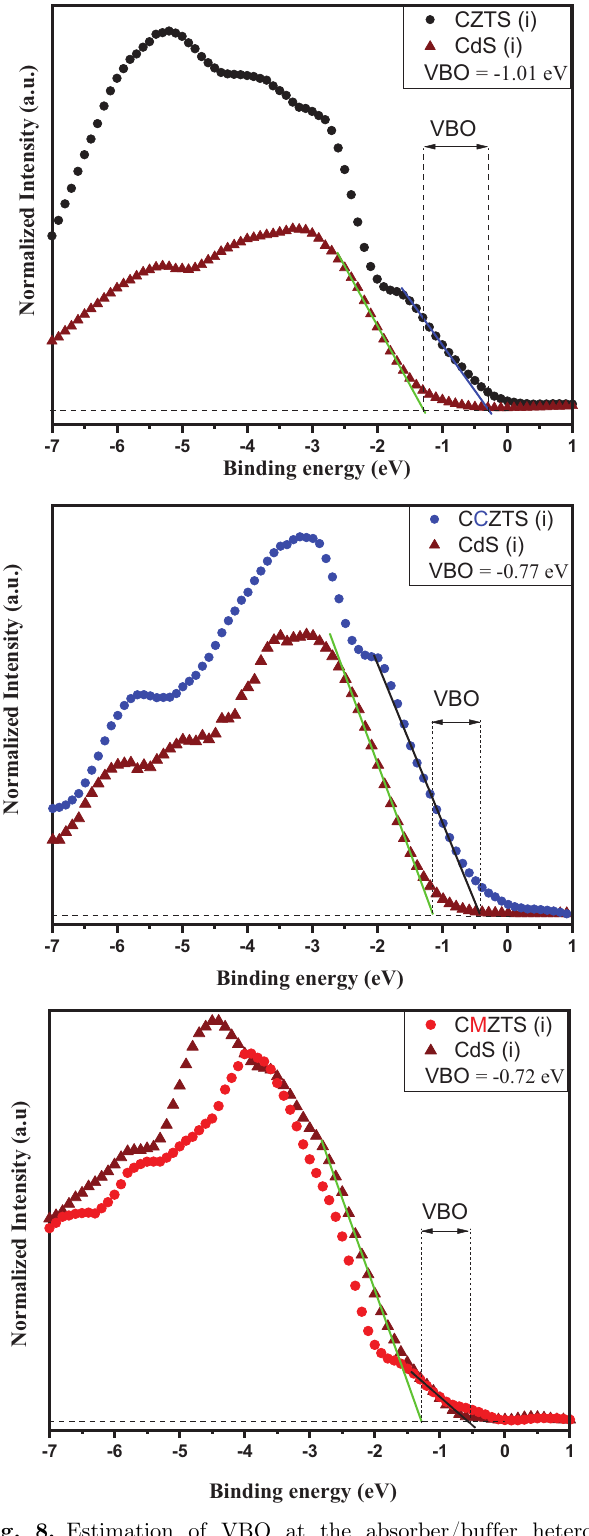
Fig. 8. Estimation of VBO at the absorber/buffer hetero- interface by direct XPS measurement. (a) CZTS/CdS, (b) CCZTS/CdS, (c) CMZTS/CdS.